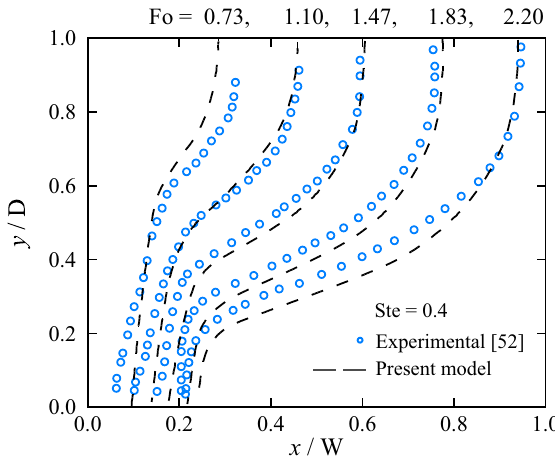
Figure 3. Comparisons of numerically determined melting-front positions in a rectangular enclosure subject to natural convection using the present model implemented in Fluent with experimental observations of isothermal melting of lead using thermal neutron radiography